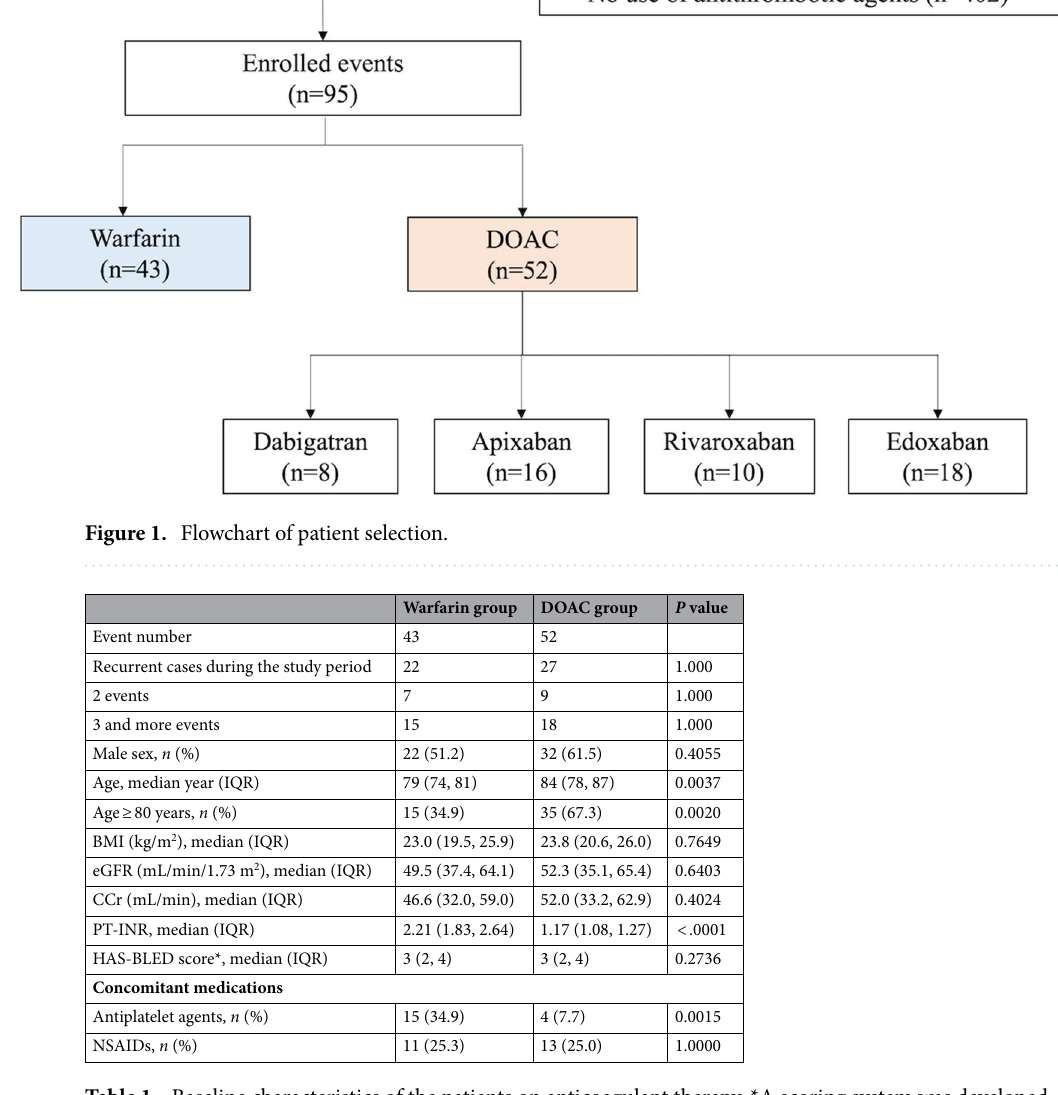
Table 1. Baseline characteristics of the patients on anticoagulant therapy. *A scoring system was developed to assess the 1 year risk of major bleeding in patients taking anticoagulants for atrial fibrillation. DOAC: direct oral anticoagulant, BMI: body mass index, eGFR: estimated glomerular filtration rate, CCr: creatinine clearance, PT-INR: prothrombin time-international normalized ratio, NSAIDs: nonsteroidal anti- inflammatory